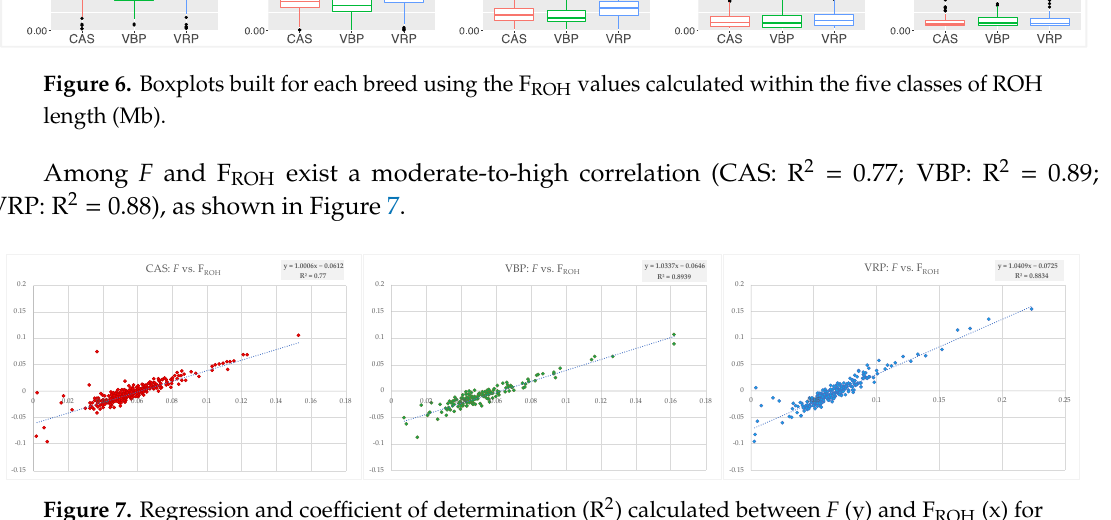
Figure 7. Regression and coe ffi cient of determination (R 2 ) calculated between F (y) and F ROH (x) for each breed.